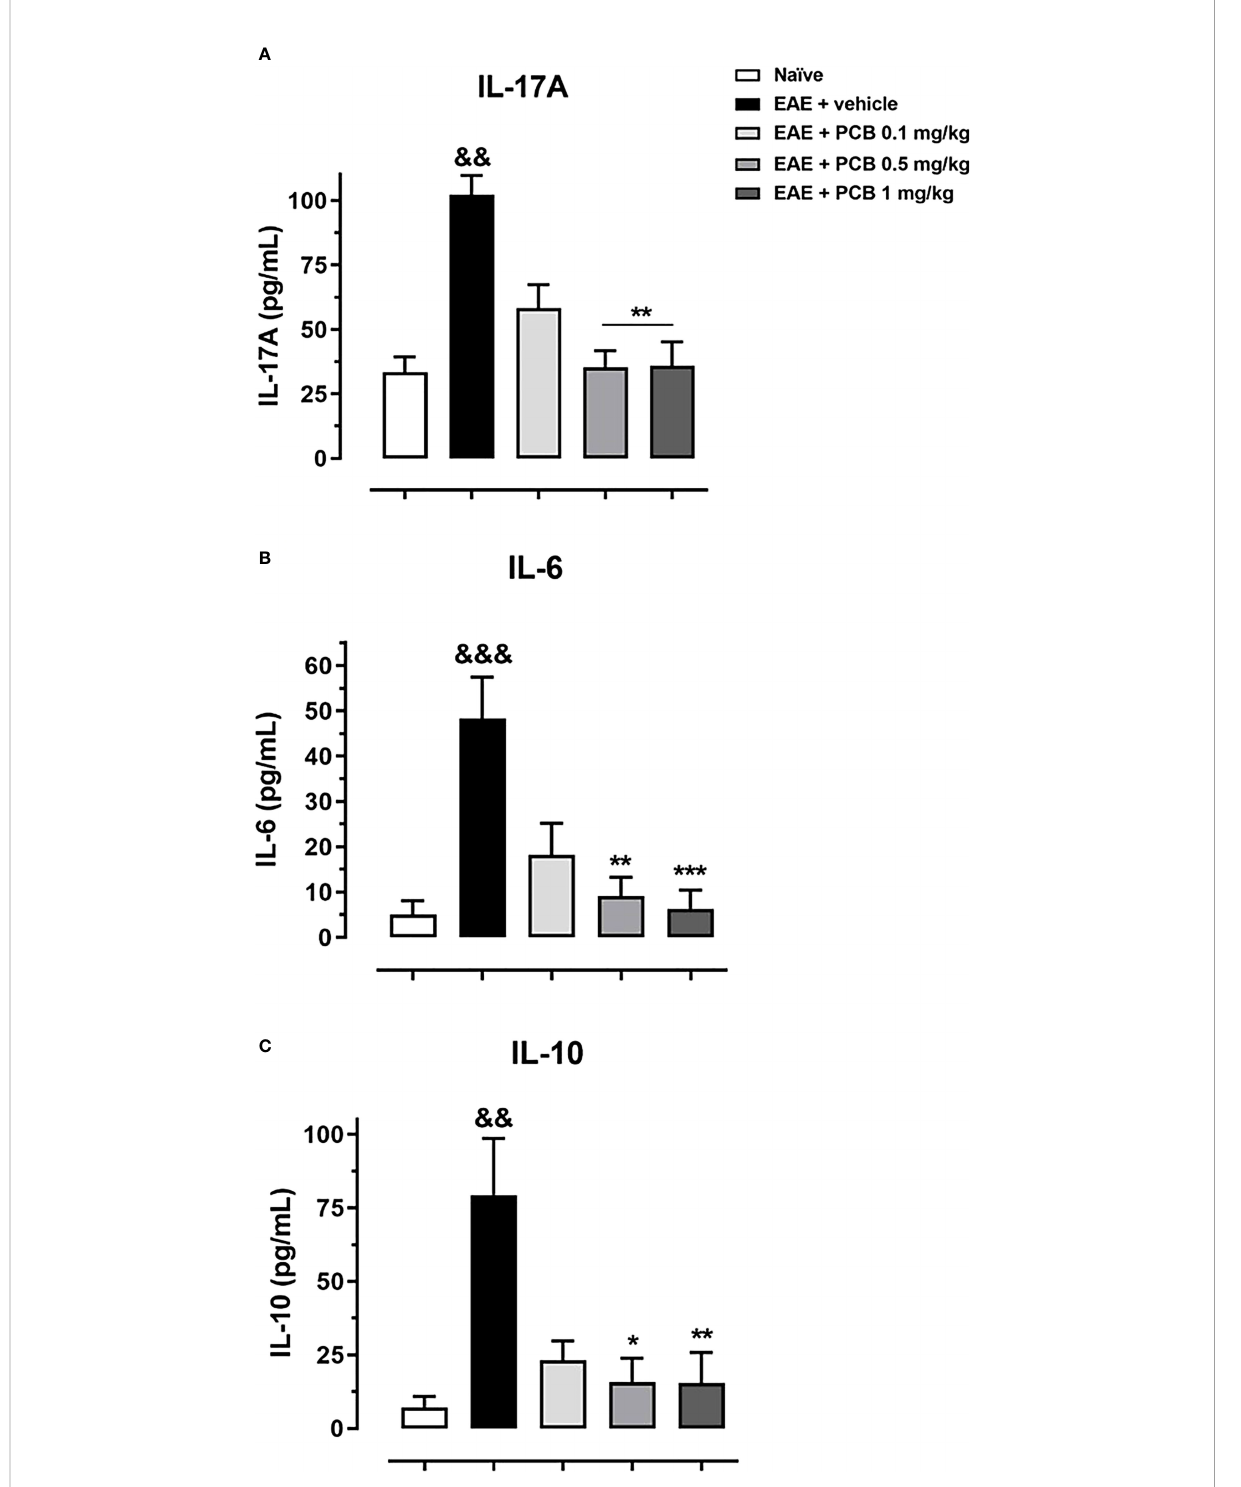
FIGURE 2 Evaluation of the PCB effect on the brain expression of cytokines in EAE mice. MOG 35 – 55 immunized mice received a daily i.p. injection of PBS (vehicle) or PCB at 0.1, 0.5 or 1 mg/kg, from day 0 until day 26 post-immunization. At this moment, the protein levels of the cytokines (A) IL- 17A, (B) IL-6, and (C) IL-10 were assessed by the respective ELISA commercial kits. Data are expressed as mean ± S.E.M. (n=6-7 per group). The ampersand (&) and asterisk (*) are indicative of signi fi cant differences with non-immunized naïve and vehicle-treated EAE mice, respectively (*p<0.05, **p<0.01, ***p<0.001; && p <0.01, &&& p <0.001, Kruskal-Wallis + Dunn ’ s